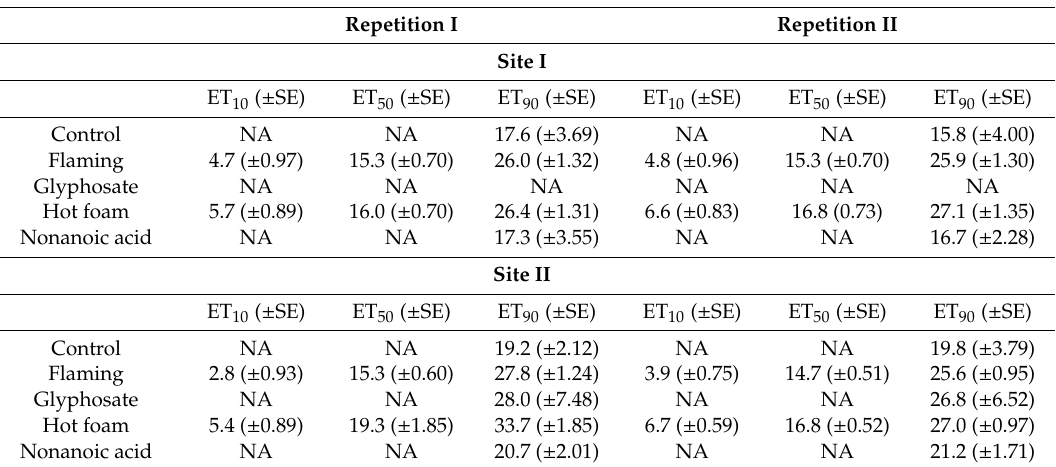
Table 6. Estimated time (days) to reach 10%, 50% and 90% weed cover regrowth (ET 10, ET 50, and ET 90, respectively) as a ff ected by the di ff erent treatments (control, flaming, glyphosate, hot foam, and nonanoic acid), the repetition (I and II) and the evaluation date in the two sites. The linear regression lines are plotted in Figure